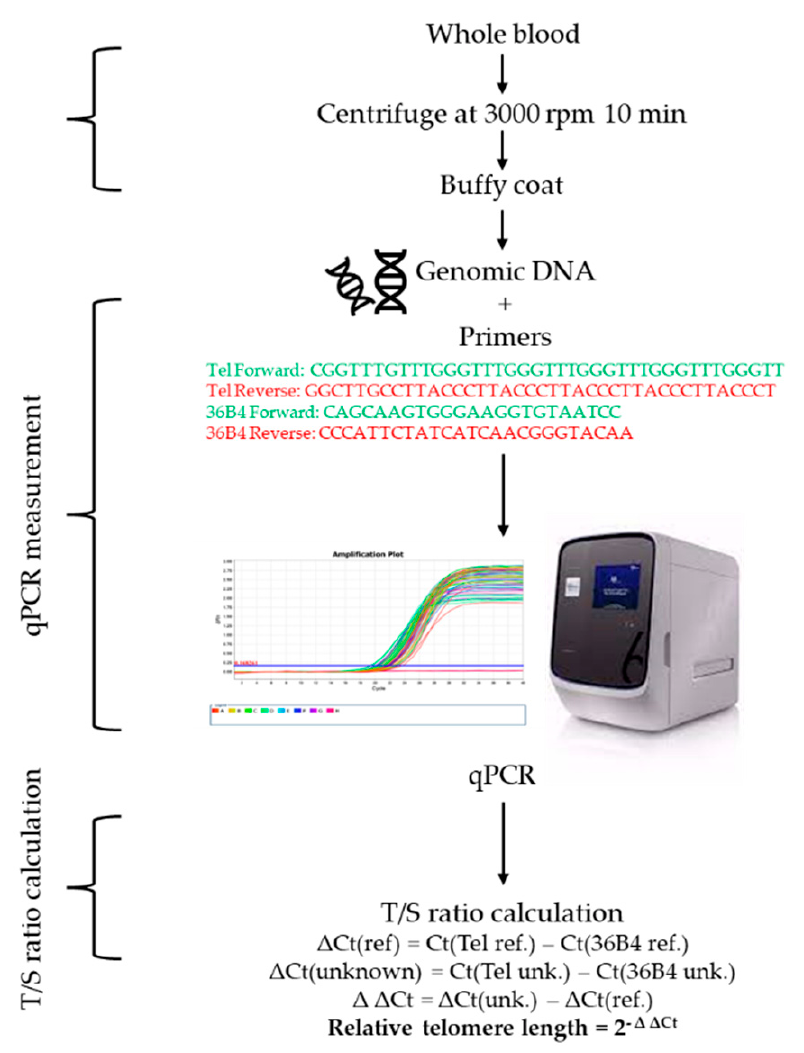
Figure 4. Diagram of qPCR blood leukocyte telomere length measurement adapted from previous study [37]. Abbreviation: DNA, Deoxyribonucleic acid; qPCR, QuantStudio 6 Flex real-time polymerase chain reaction.